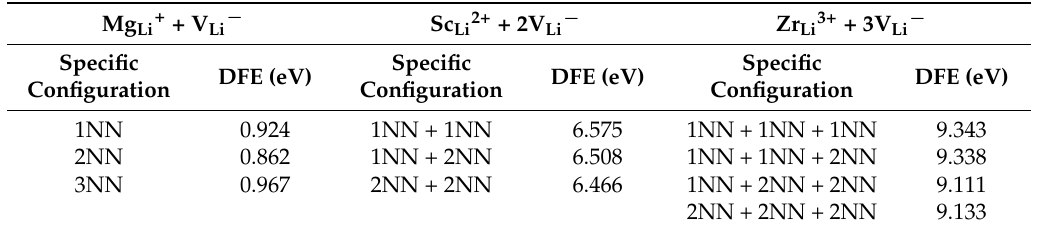
Table 2. Formation energies of specific configurations of Mg Li+ + V Li − , Sc Li2+ + 2V Li − , and Zr Li3+ + 3V Li −